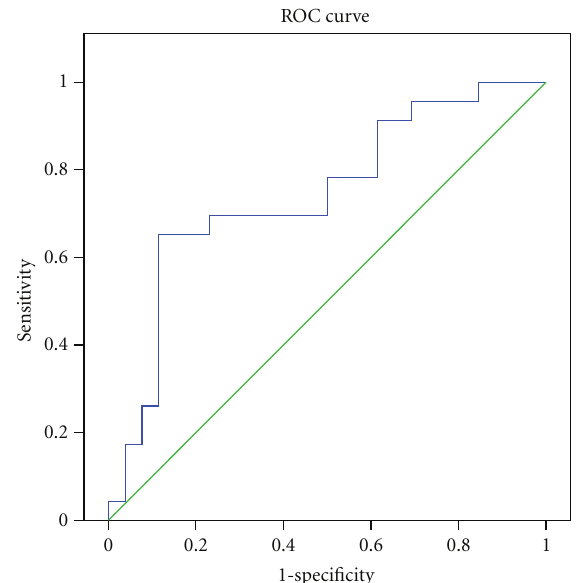
Figure 1: ROC curve analysis ( P = 0,004 and area under the curve (AUC) =